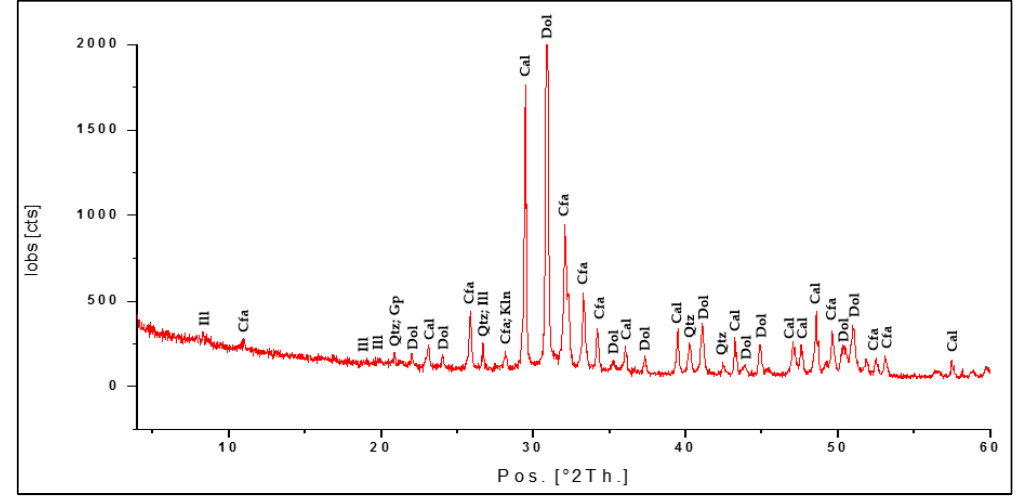
Figure 2. X ‐ ray diffractogram of the raw phosphate sample showing the presence of: carbonate ‐ fluorapatite (Cfa), calcite (Cal), dolomite (Dol), illite (Ill), kaolinite (Kln), gypsum (Gp) and quartz (Qtz).